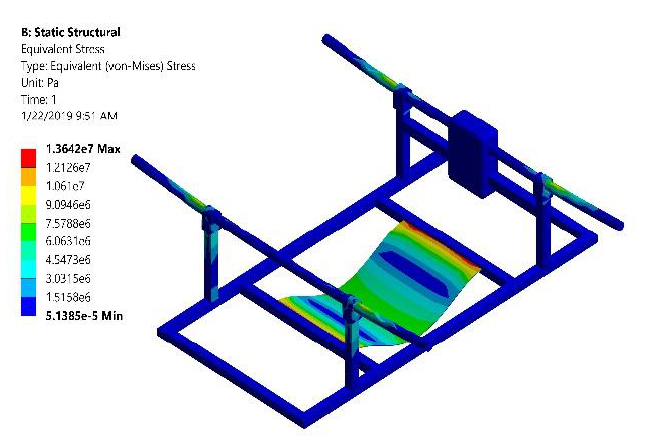
Figure 4. Stress contour of UAV frame